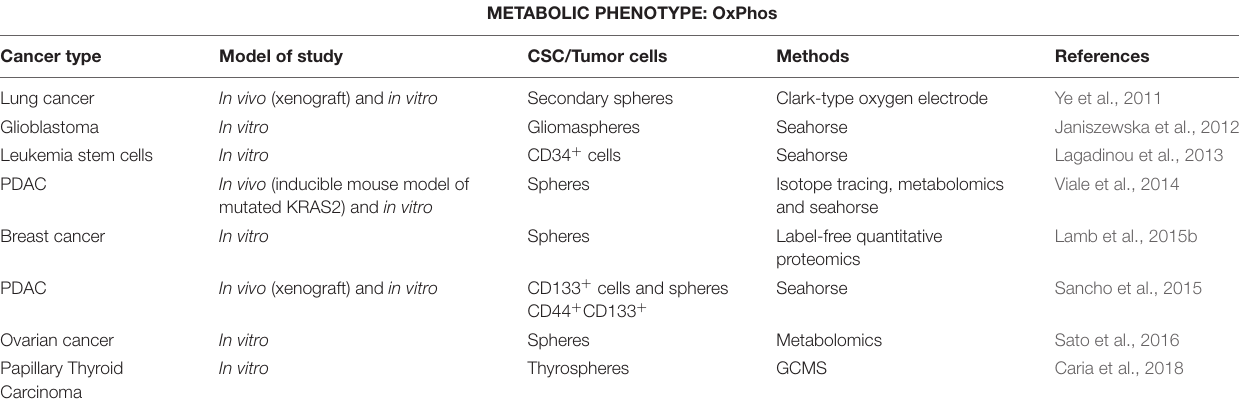
TABLE 2 | Stem-like cells with OxPhos metabolism for various cancer types (in chronological